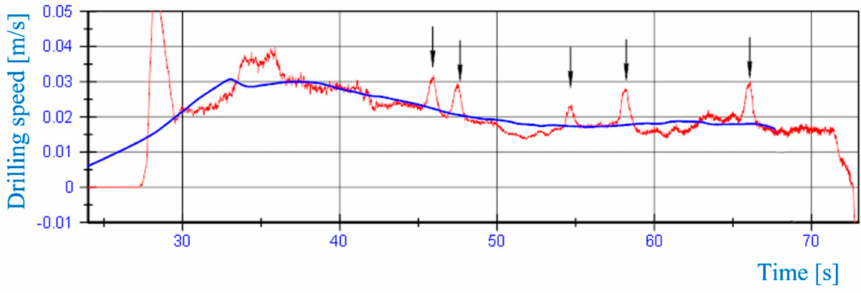
Figure 9. Drilling speed for the first rod of borehole No. 6 marked with the trend